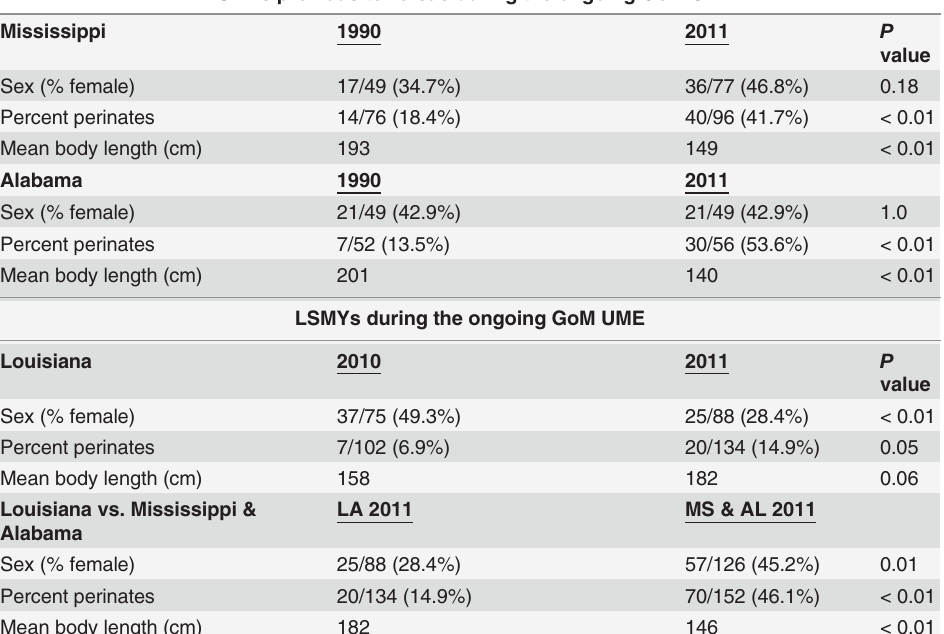
Table 1. Comparison of demographics for common bottlenose dolphins ( Tursiops truncatus ) stranded in Mississippi and Alabama during shared large-scale mortality years (LSMY) 1990 and